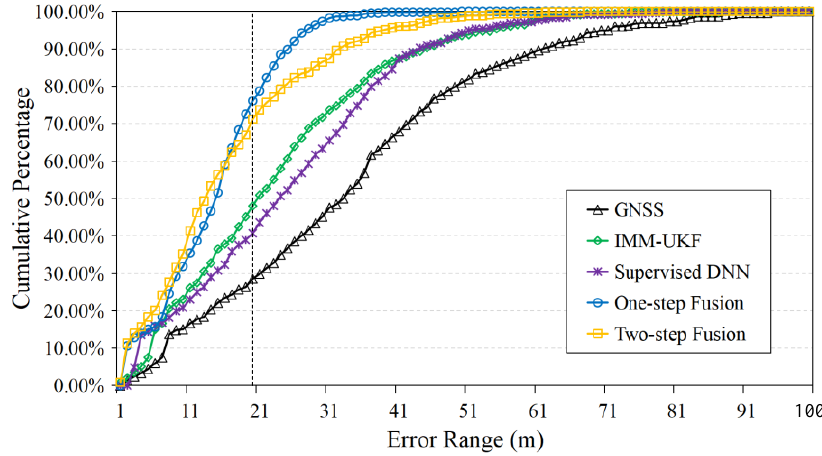
Figure 8. Cumulative percentage curves in different location error range in Scenario 1.